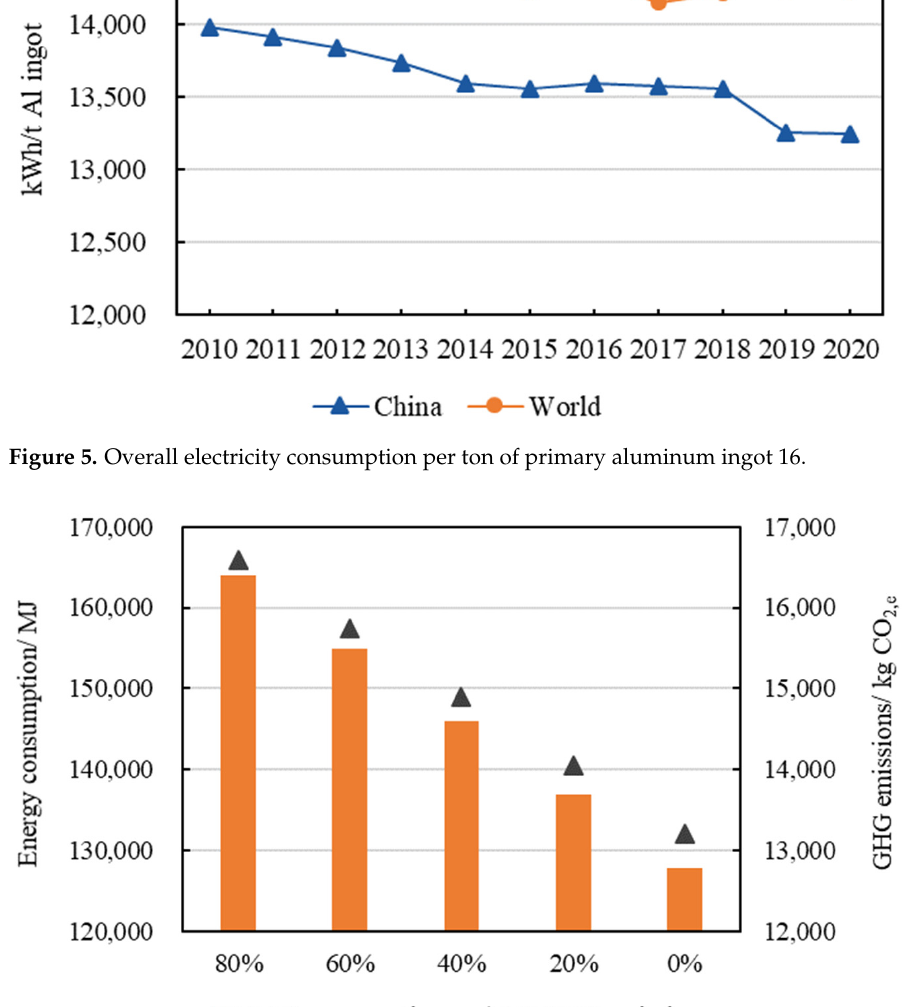
Figure 5. Overall electricity consumption per ton of primary aluminum ingot 16.